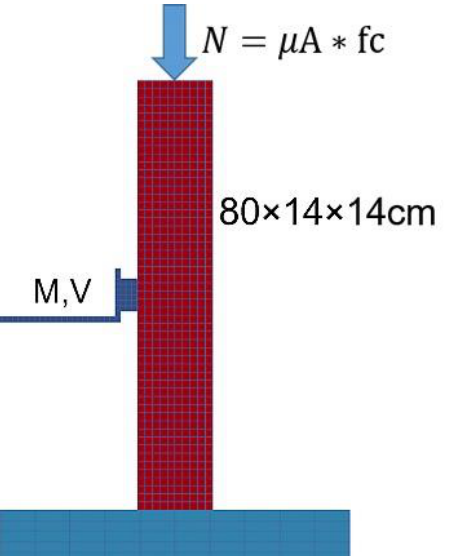
Figure 25. Finite element model considering influence of axial pressure ratio. The relationship between peak contact force and axial pressure ratio is given in Figure 26. The peak contact interface force increased with the increase in the axial compres- sion ratio under the same impact energy. In addition, the peak contact interface force at the same axial pressure ratio and the contact holding time increased with the increase in the impact speed. The relationship between column top displacement and axial pressure ratio is given in Figure 27. With an increase in the axial compression ratio, the column top displacement decreased. With an increase in the axial compression ratio in the scenario of higher impact velocity, the displacement of the top of the column increased more quickly. The damage area and failure mode of the impact scenario model did not differ noticeably, and the damage area of the model column was primarily on the collision side of the root. The peak contact interface force increased to a certain extent due to the stress stiffness caused by the increased axial compression ratio, which also reduced the impact deformation of the